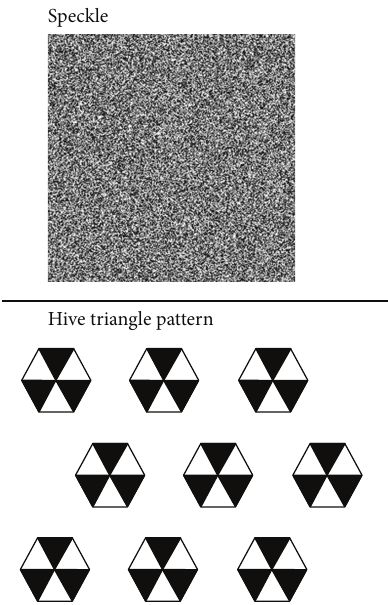
Figure3:Animageframethatincludesthespeckleandhivetriangle patterns is used as reference object in numerical